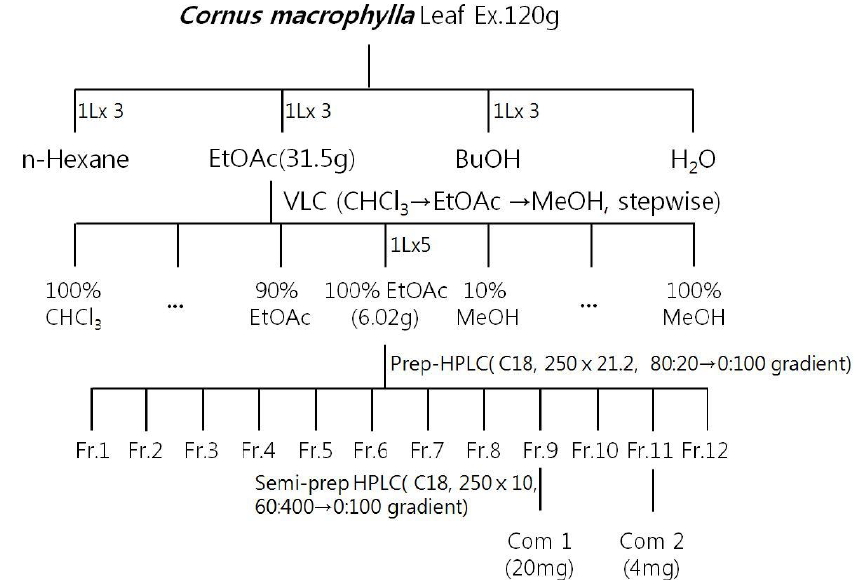
Figure 1. Isolation of compounds 1 and 2 from the leaves of Cornus macrophyllla.